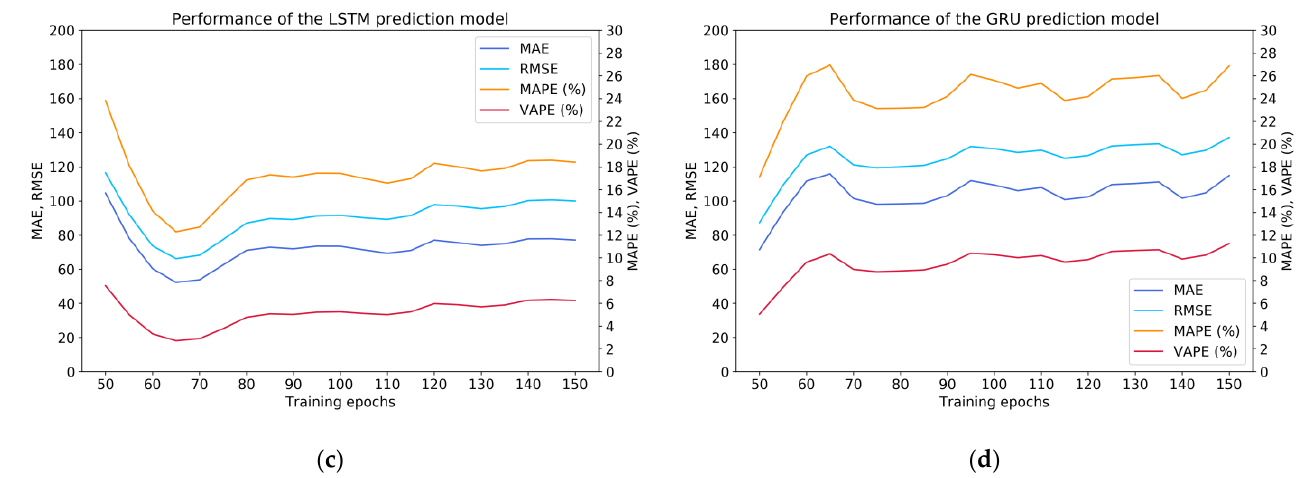
Figure 6. Prediction performance of four deep neural network models: ( a ) performance of the ISTL-LSTM model (the performance was the best when epochs = 65); ( b ) performance of the STL-LSTM model (the performance was the best when epochs = 100); ( c ) performance of the LSTM model (the performance was the best when epochs = 65); ( d ) performance of the GRU model (the performance was the best when epochs = 50).